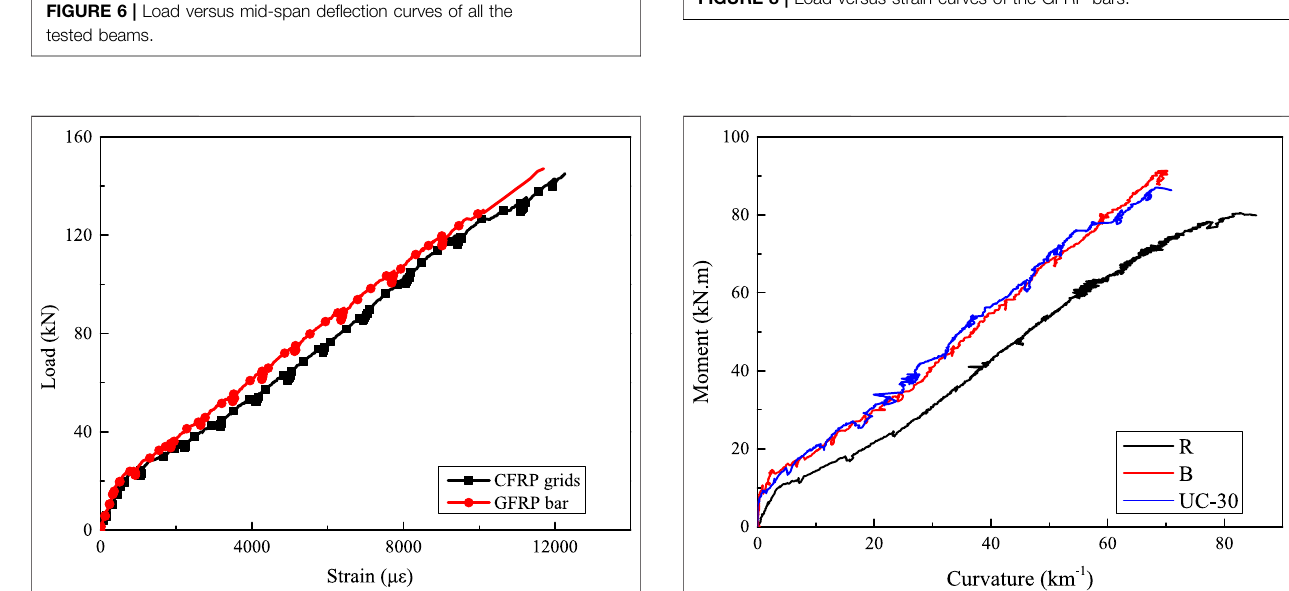
FIGURE 8 | Load versus strain curves of the GFRP bars.